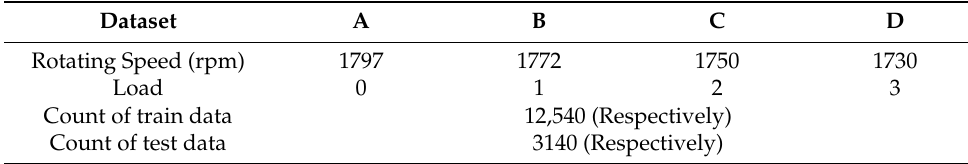
Table 4. Description of the CWRU dataset.